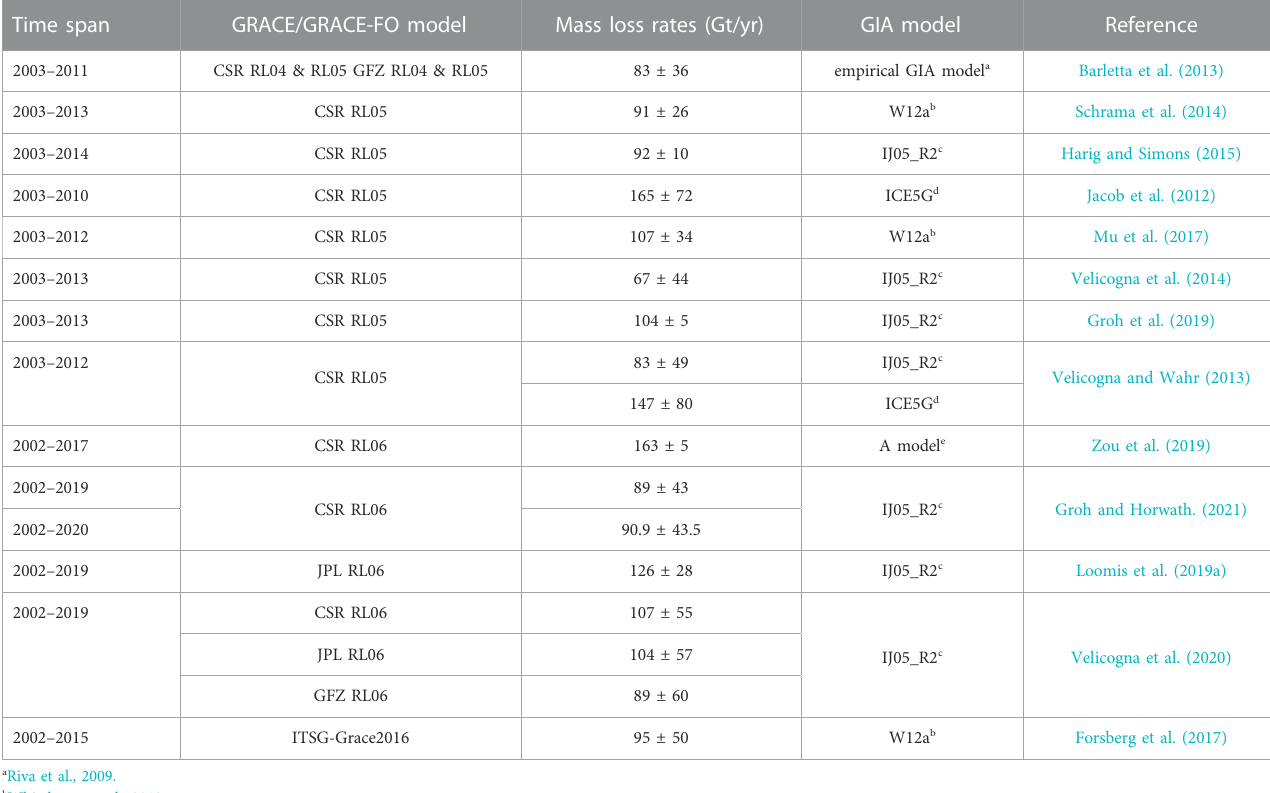
TABLE 1 Mass loss rates over AIS with GIA